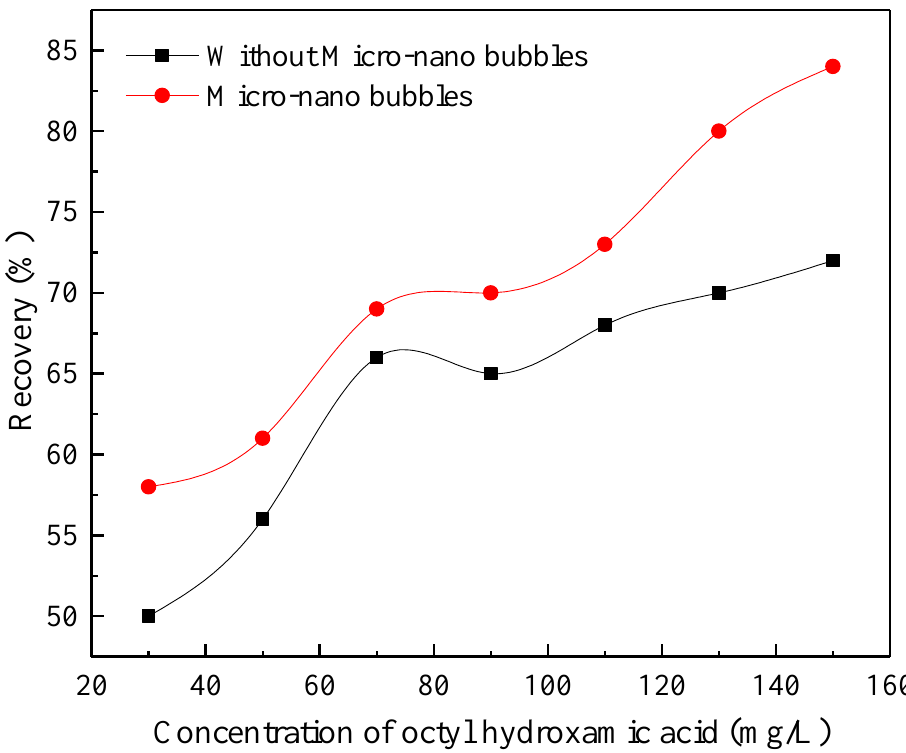
Figure 6. The relationship between the recovery rate and the amount of octyl hydroxamic acid (pH = 10).